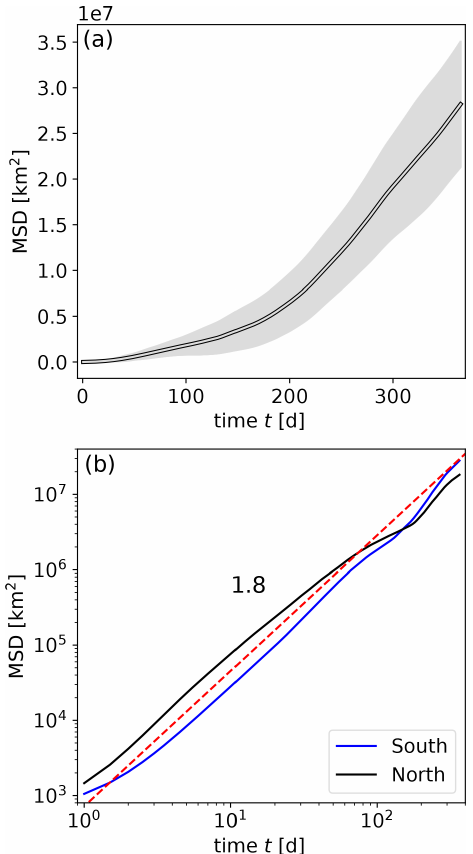
Figure 7. Time-averaged mean squared displacement (TAMSD) for the advected parcels in units of km 2 . The spherical geometry was fully taken into account when calculating distances in moving time windows of size w . (a) TAMSD for the northern subset (lin-lin plot). The error band reflects the standard deviation obtained from year- by-year statistics. (b) TAMSDs for both the northern (black) and southern (blue) subsets of parcels on a double-logarithmic scale. The dashed red line illustrates a power law with an exponent value of around